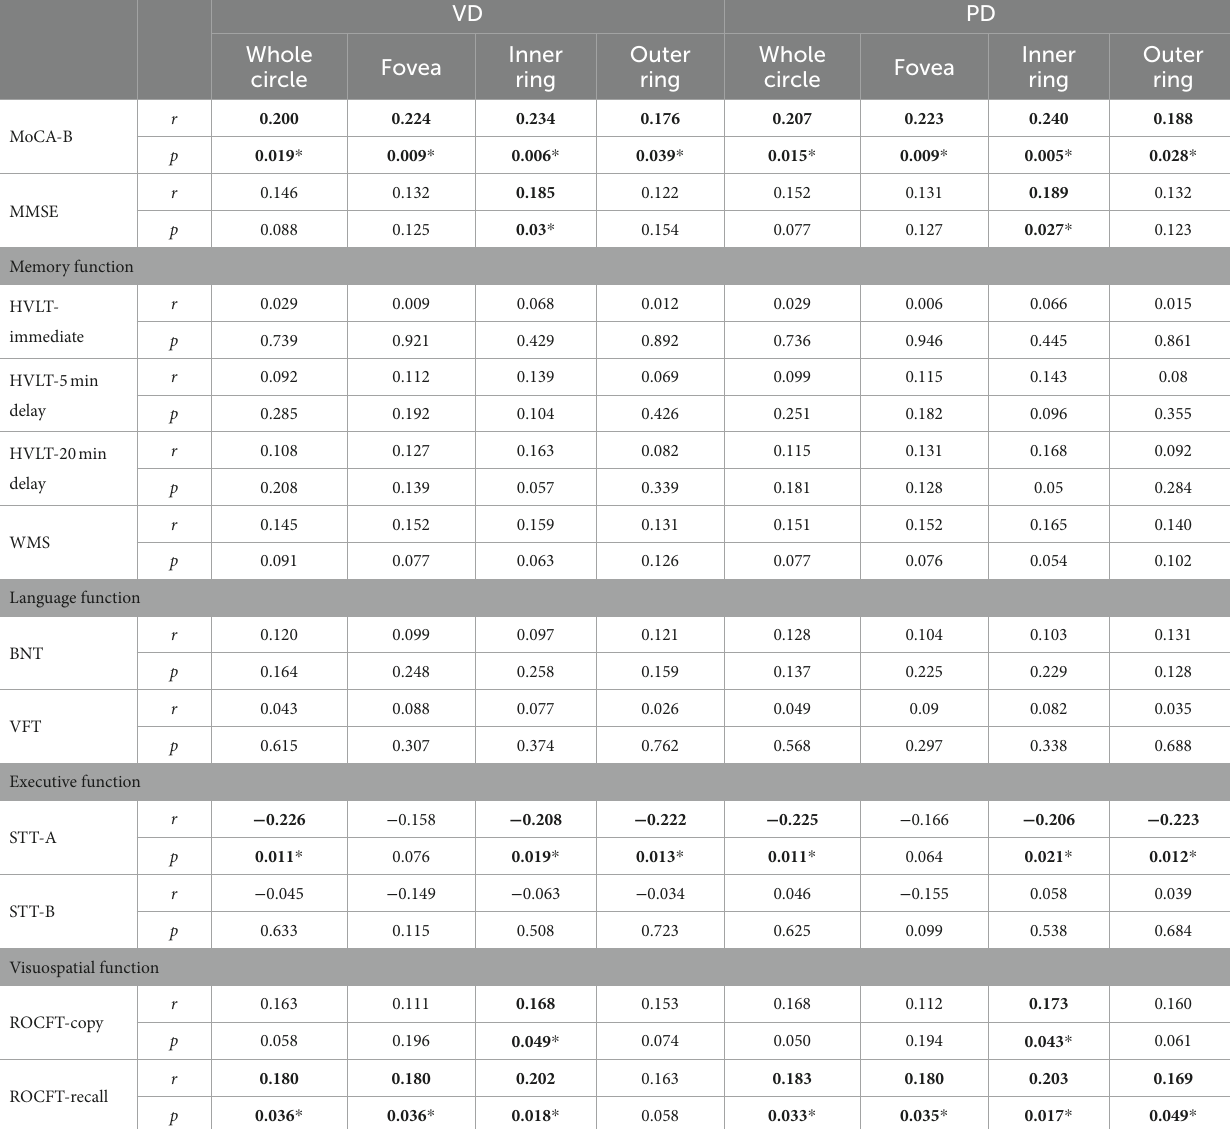
TABLE 5 Correlation between retinal blood flow and cognitive